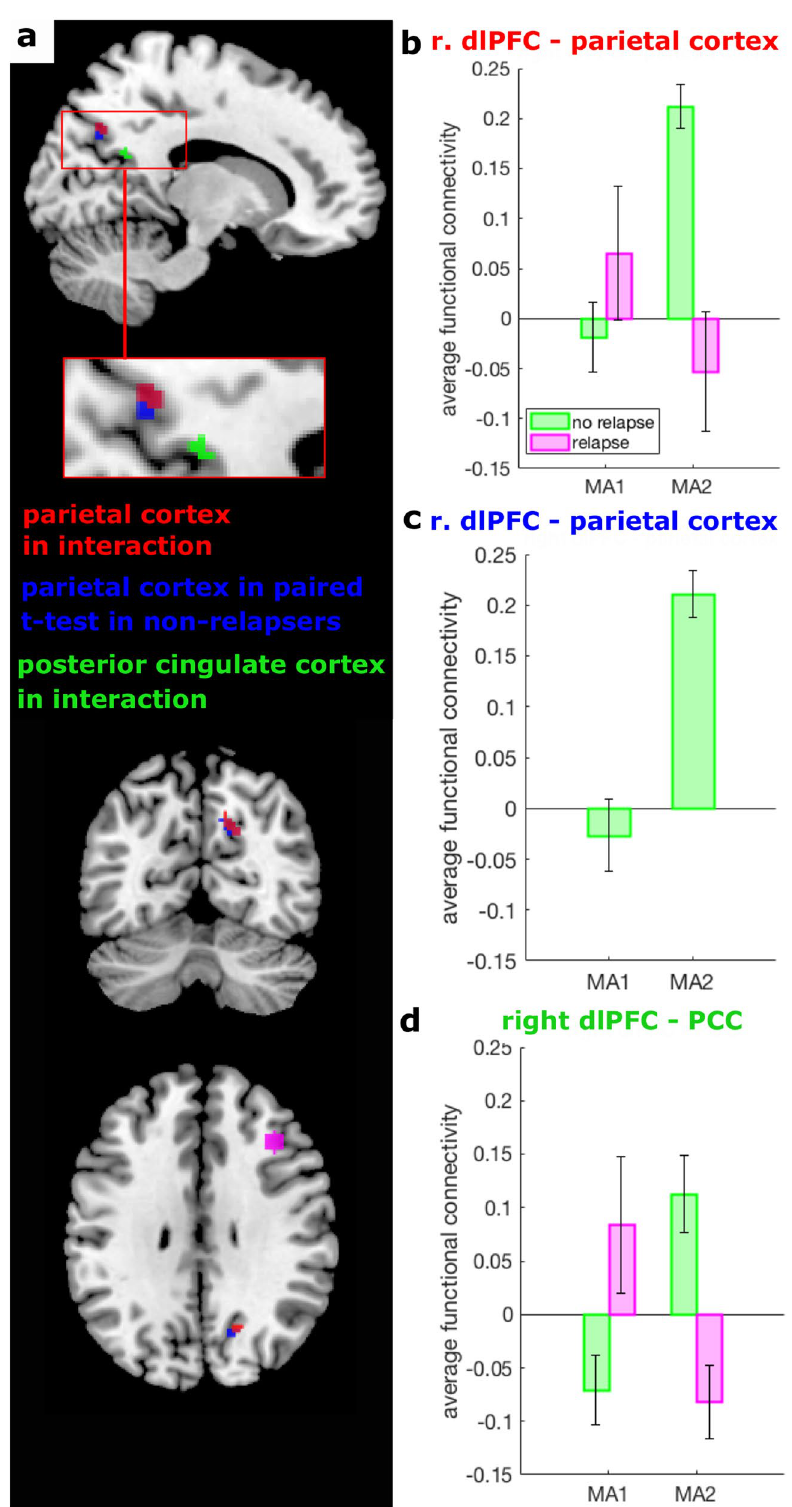
Figure 3. Discontinuation relapse interaction effect: ( a ) Depicted are clusters for significant interactions between discontinuation and relapse between our choosen seed in the right dorsolateral prefrontal cortex (dlPFC, magenta) and the parietal cortex (red) and the posterior cingulate cortex (PCC, green) and a paired t -test in non-relapsers only for RSFC between right dlPFC and the parietal cortex (blue). ( b – d ) The Fisher z-transformed average functional connectivity between the right dlPFC and the surviving clusters in the parietal cortex and the PCC is depicted for the interaction between relapsers and non-relapsers ( b , d , respectively). Specifically, depicted are significant interaction effects with p < 0.0083 which survive our threshold corrected for multiple comparison. Exact p values are given in Table 2. ( c ) The paired post-hoc t -test in non- relapsers for the interaction effect in relation to the parietal cortex shown in ( b ). Error bars indicate standard